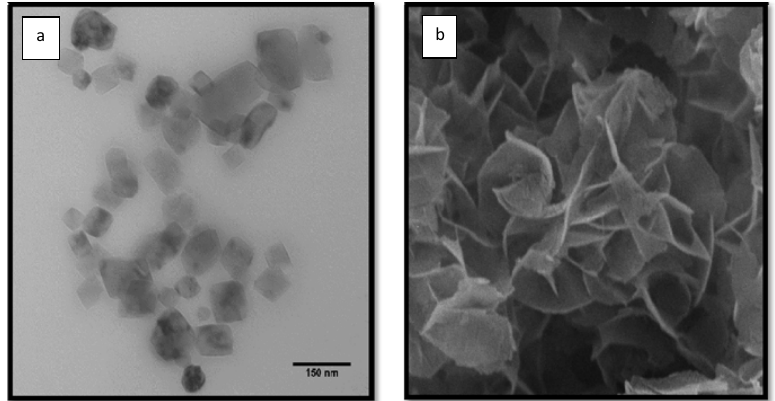
Fig. 2. The characterization of synthesized MgO NPs. (a) Transmission electron microscopy (TEM); (b) Scanning Electron Microscopy (SEM)